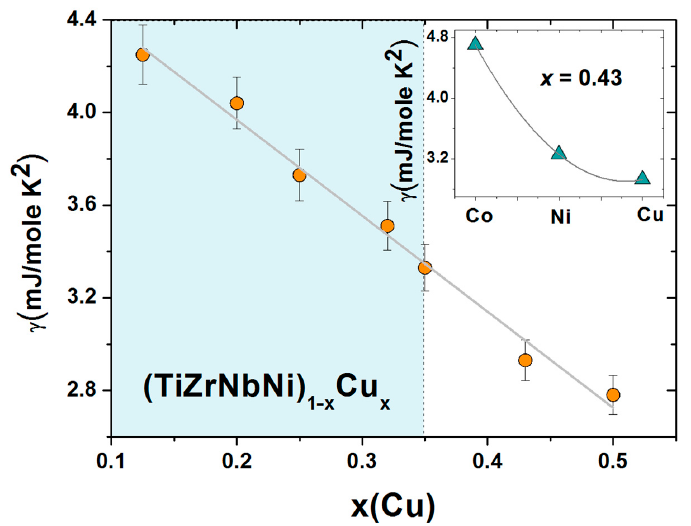
Figure 13. Sommerfeld coefficient γ of (TiZrNbNi) 1 − x Cu x MGs vs. x . The inset: γ of alloys with x = 0.43 Co, Ni and